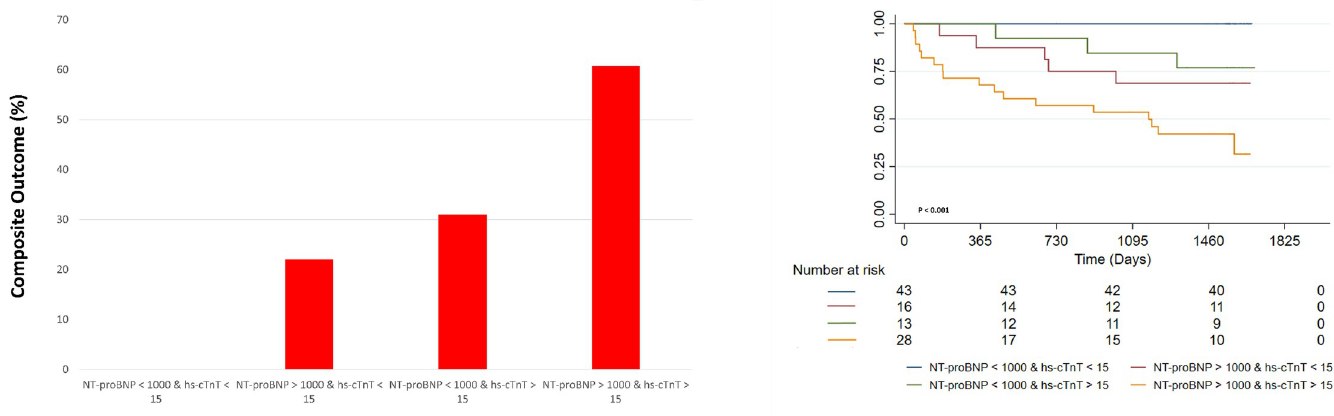
Fig 3. Bar graph and Kaplan Meier survival analyses for the composite outcome stratified by combined NT-proBNP and Hs-cTnT according to selected cut-off values.